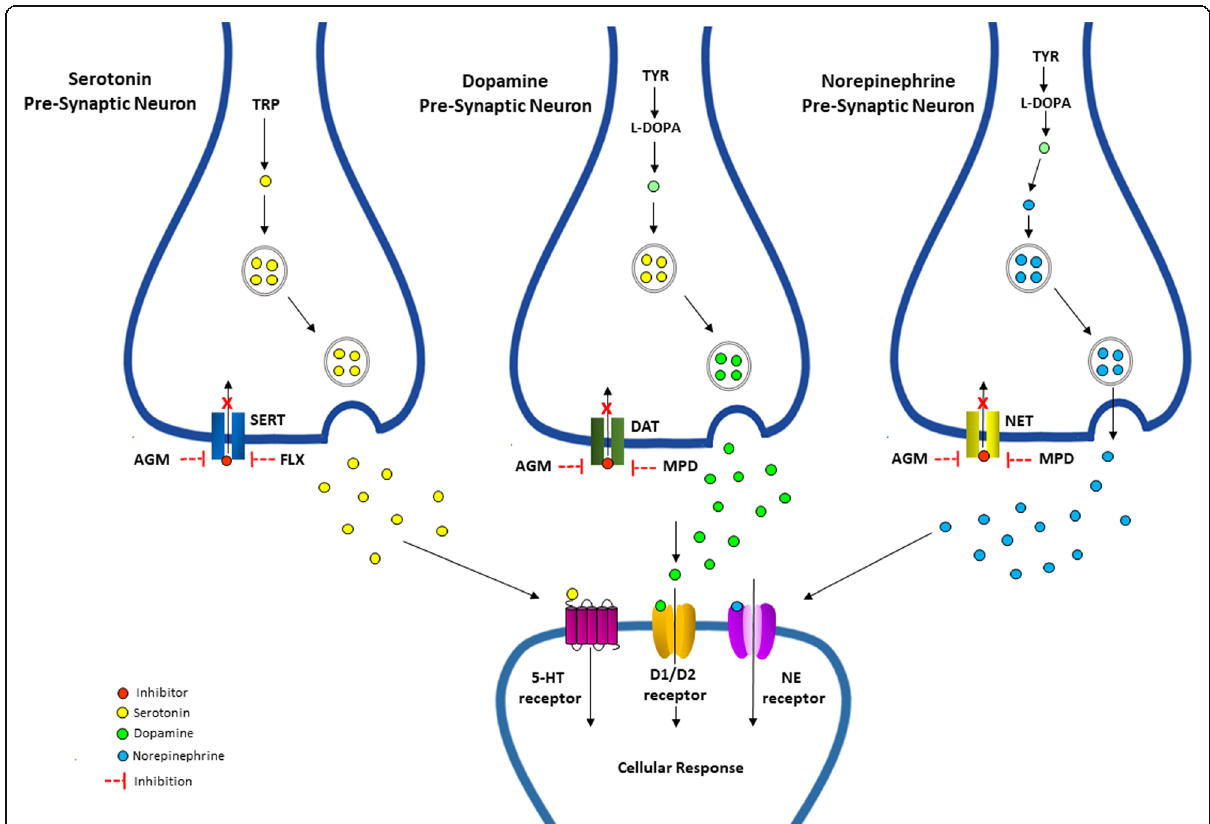
Fig. 1 Potential mechanism of action of agmatine as monoamine reuptake inhibitor. Agmatine (AGM) may block serotonin reuptake transporter (SERT) found on presynaptic neuron. This leads to increase in serotonin (5-HT) levels at synaptic cleft thus induces cellular response at post- synaptic neuron. AGM may also inhibit dopamine reuptake transporter (DAT) and norepinephrine reuptake transporter (NET) at pre-synapse. Similar to serotonin, inhibition of DAT and NET leads to elevated levels of dopamine (D) and norepinephrine (NE) at synaptic cleft. The mechanism of action of AGM at monoamine reuptake transporters is similar to fluoxetine (FLX) and methylphenidate (MPD) at SERT, DAT, and NET, respectively. Consequently, monoamines bind to their specific post-synaptic receptors efficiently and lead to improved mood and anxiolytic and learning